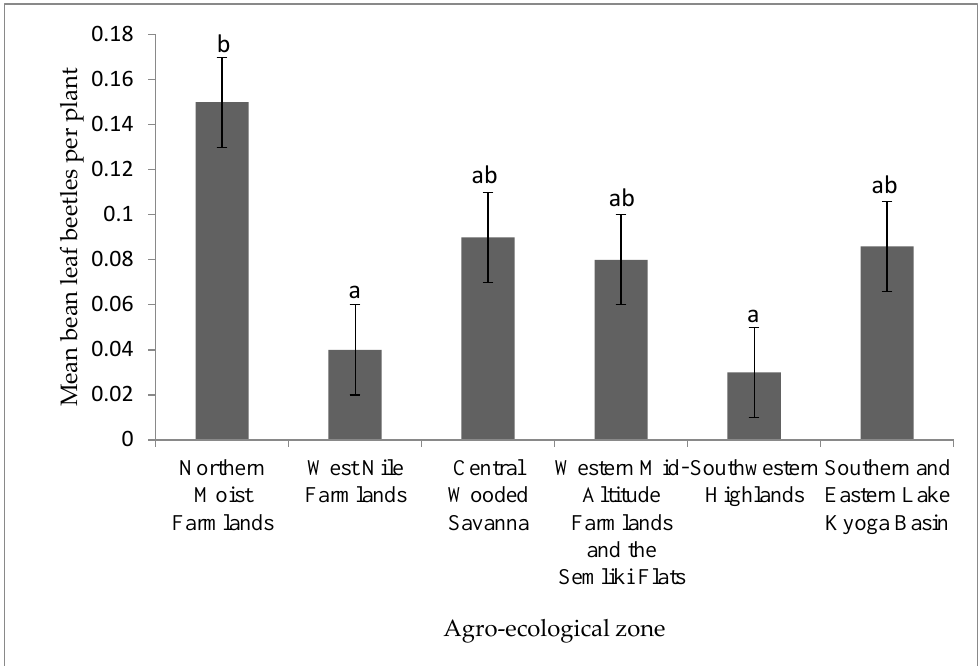
Figure 4. Incidence of bean leaf beetles in different agro-ecologies in Uganda. Bars bearing the same letter or letter combination are not significantly different at p = 0.05.